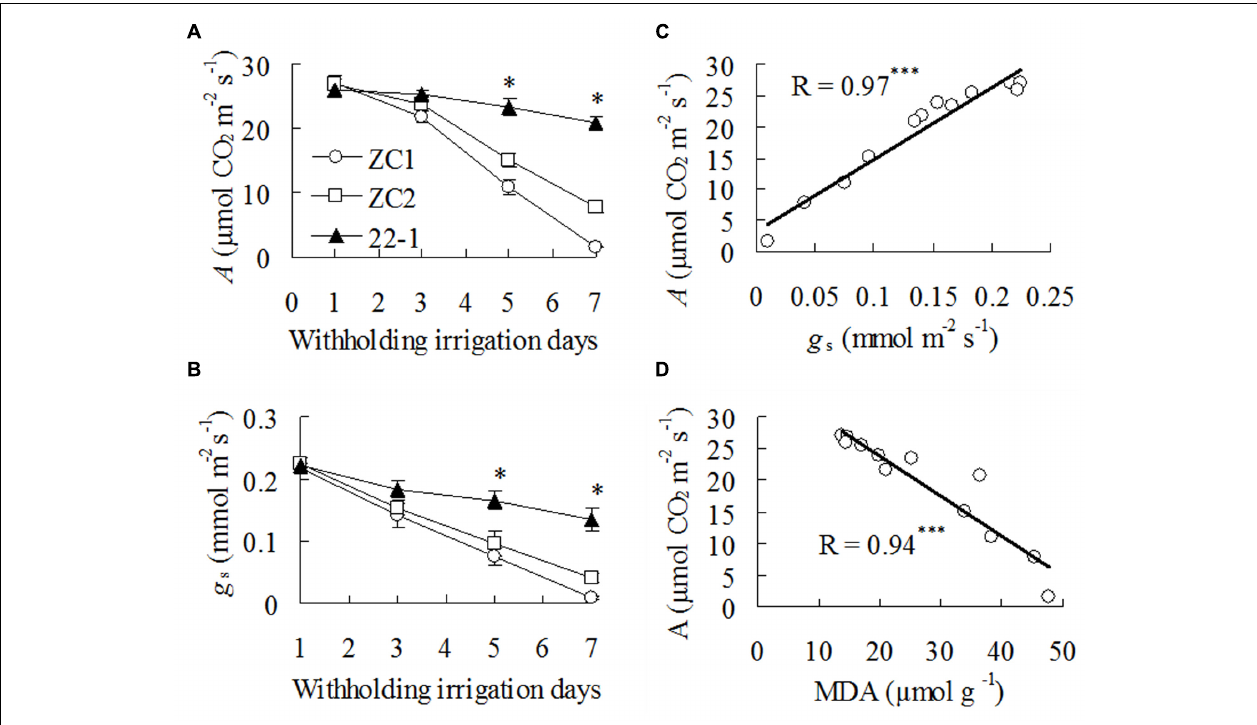
FIGURE 2 | Net photosynthetic rate (A) and stomatal conductance ( g s ) in the mutant 22-1 and the wild type plants (ZC1, ZC2) and correlation of A with g s and MDA during drought stress. A (A) and g s (B) were measured at the dates as indicated in the figures. Correlation of A with g s (C) and MDA (D) and during withholding irrigation were analyzed using linear regression. Means of three pots of plant samples and the standard errors are presented; the asterisks ∗∗∗ indicate significant difference between 22-1 and the wild types at P <